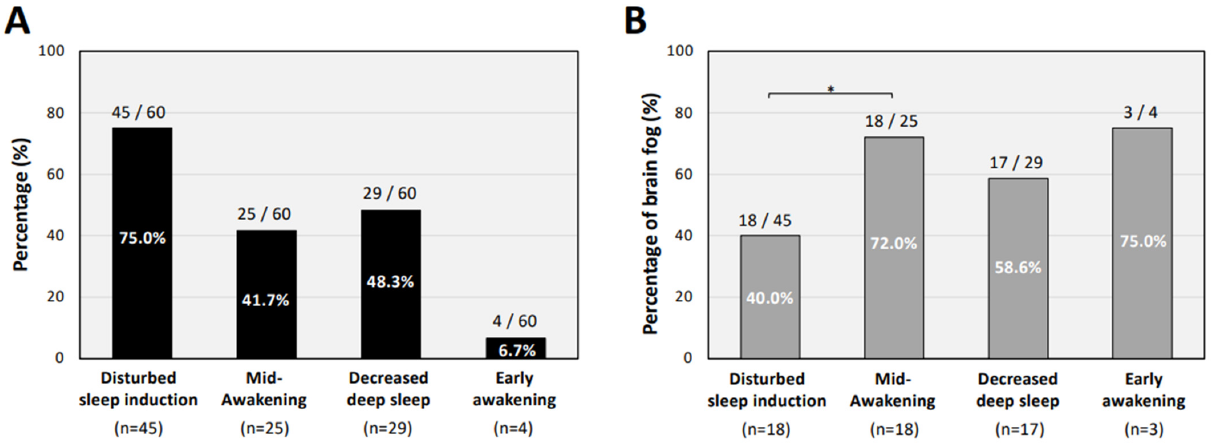
Figure 3. Types of insomnia in long COVID patients with sleep disturbance. ( A ) Four types of sleep disturbance, including disturbed sleep induction, mid-awakening, decreased deep sleep, and early awaking in long COVID patients with insomnia. ( B ) Prevalence of brain fog symptoms in long COVID patients with each type of insomnia. The χ 2 test was performed for each symptom between the groups and * p < 0.05 was considered as statistically significant.